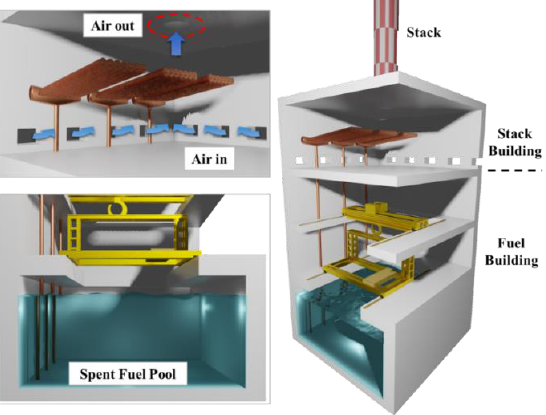
Figure 3. Conceptual drawing of a passive spent fuel pool cooling system using FHPs.